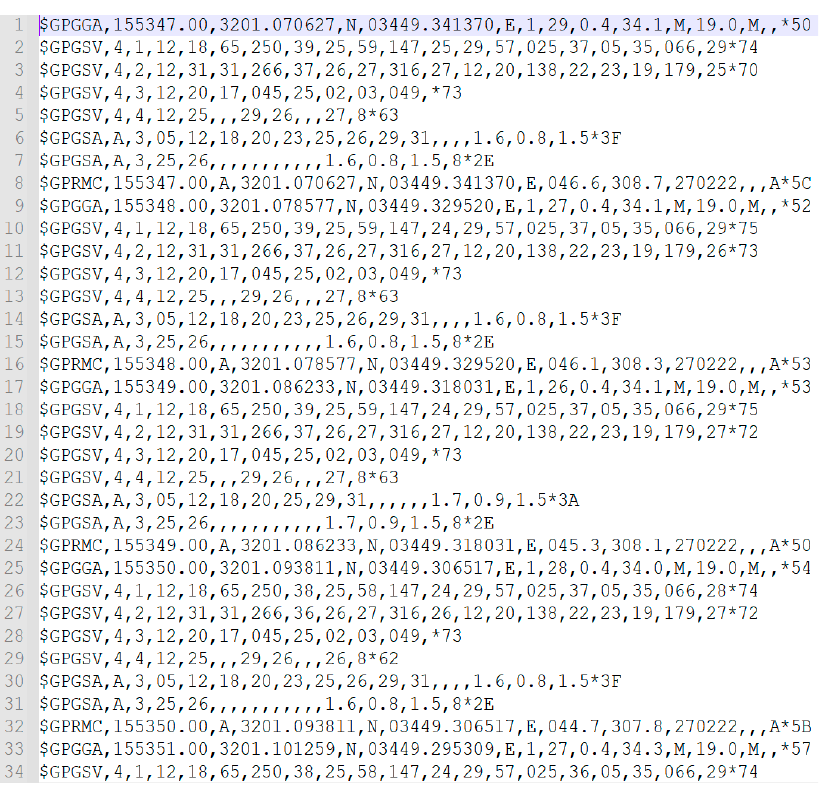
Figure A3. Example of incorrect information in a database. Figure A4. Case with different number of GPGSV lines.